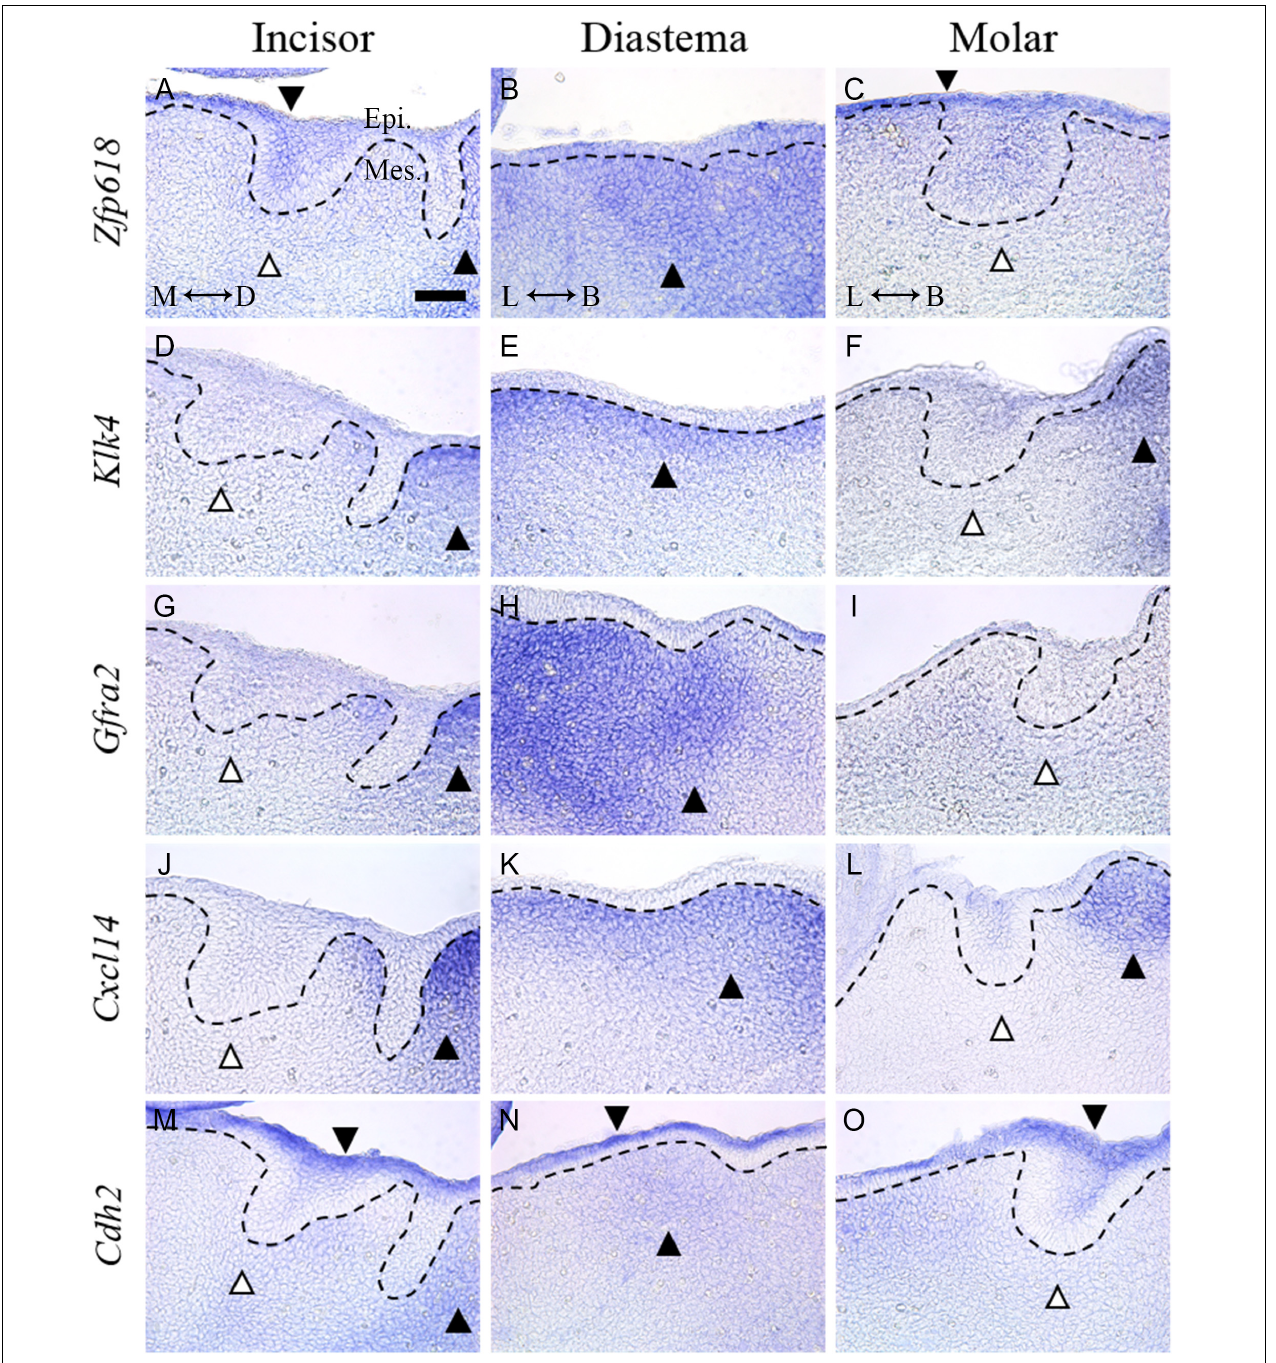
FIGURE 5 | In situ hybridization of five genes selected from the DEG list showing UD pattern in TS E12.5. (A) Zfp618 was shown in the oral epithelium and incisor tooth germ epithelium. It was also expressed in the distal side of the vestibular lamina. (B) Zfp618 was expressed in the diastema mesenchyme. (C) In the molar, it was weakly expressed in the oral epithelium of the molar region. (D) Klk4 was observed in the distal side of the incisor vestibular lamina (E) and diastema mesenchyme beneath the oral epithelium. (F) Klk4 was not expressed in the molar region. (G) Gfra2 was expressed in the distal side of the incisor vestibular lamina. (H) It was strongly and broadly expressed in the diastema mesenchyme region. (I) In the molar region, Gfra2 expression was not observed. (J) Cxcl14 expression pattern in the incisor region is similar to Gfra2 and Klk4 . (K) In the diastema, Cxcl14 was observed beneath the oral epithelium. (L) In the molar region, Cxcl14 is expressed in the distal side mesenchyme of the molar tooth germ. (M–O) Cdh2 was expressed in the whole oral epithelium of the embryo dental arch. Cdh2 was also expressed in the diastema mesenchyme; however, it was not expressed in the mesenchyme of odontogenic regions. Dotted lines indicate the basal lamina. Black arrow heads indicate expressed region. White arrow heads indicate not expressed region. M, mesial; D, distal; L, lingual; B, buccal; Epi., epithelium; Mes., mesenchyme; scale bar: 50 µ m.